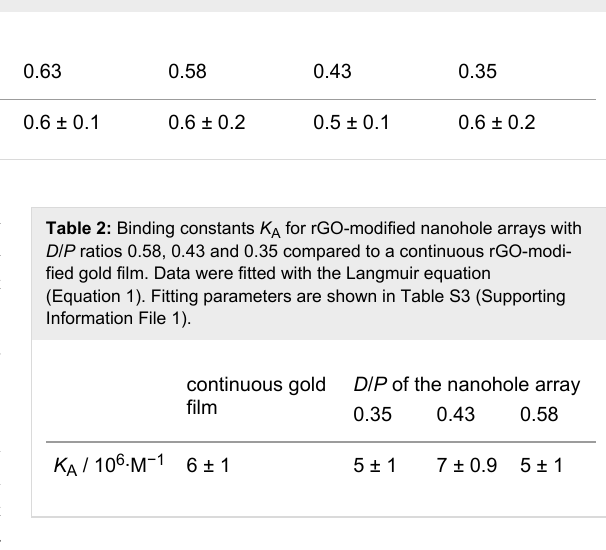
Table 1: Change in SPR resonance angle of nanohole arrays with different D / P -ratios compared to a continuous gold film. Each value represents the average value of three measurements. Errors indicate the standard deviation of these measurements.